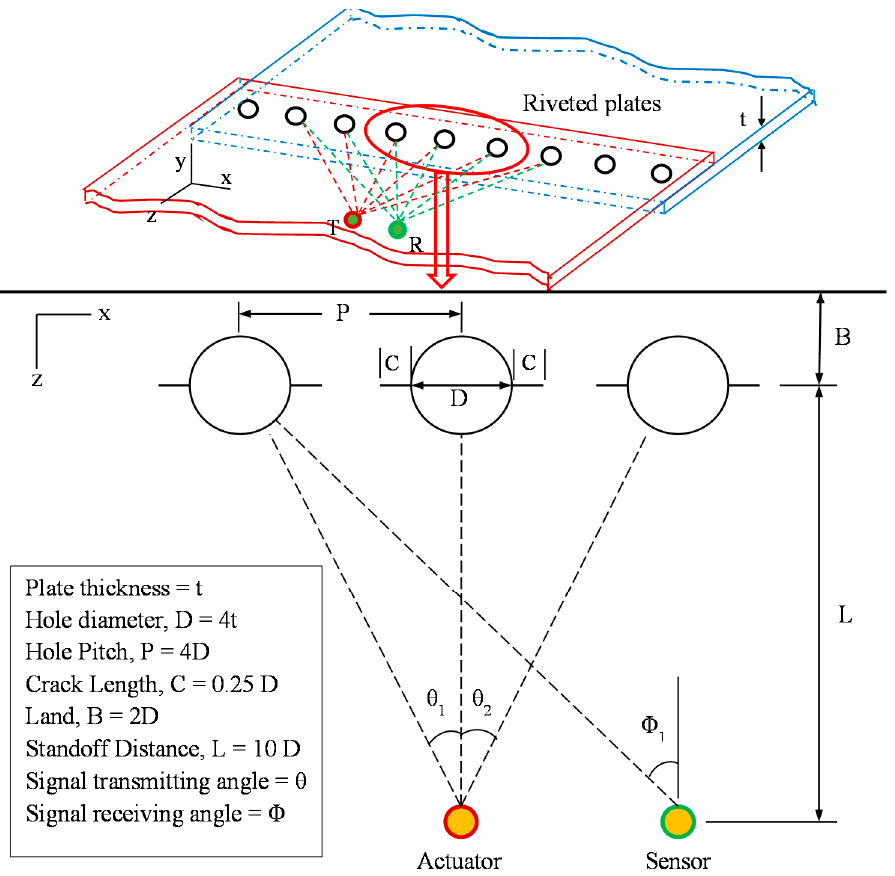
Figure 1. Illustration of the multiple-rivet-hole lap joint.